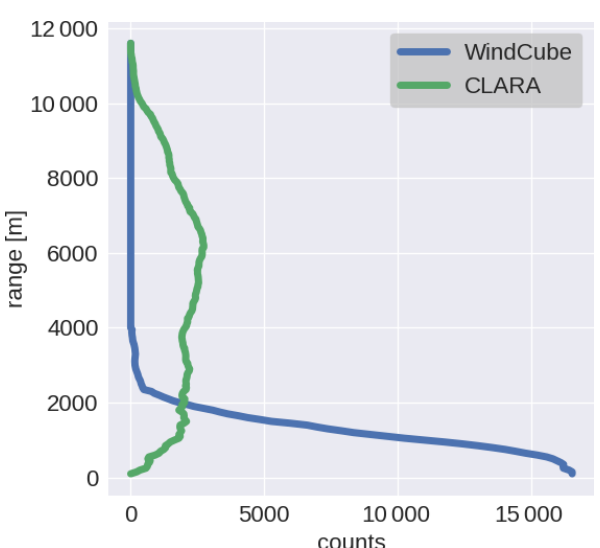
Figure 13. Distribution of level 2 data source stratified with height: WindCube in blue and CLARA in